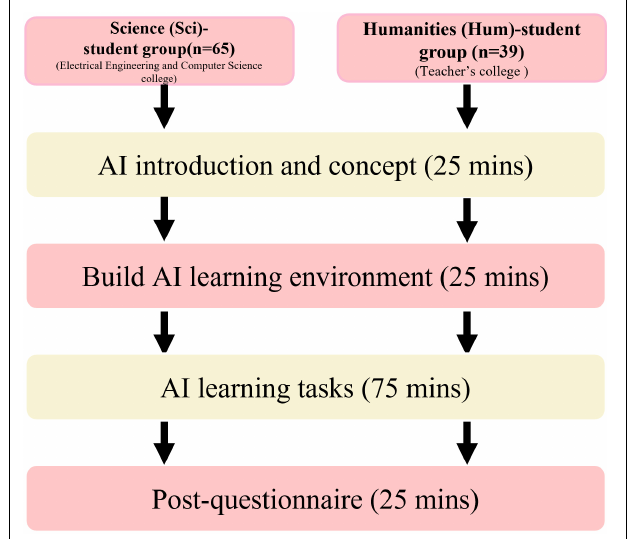
FIGURE 2 | AI course research process.